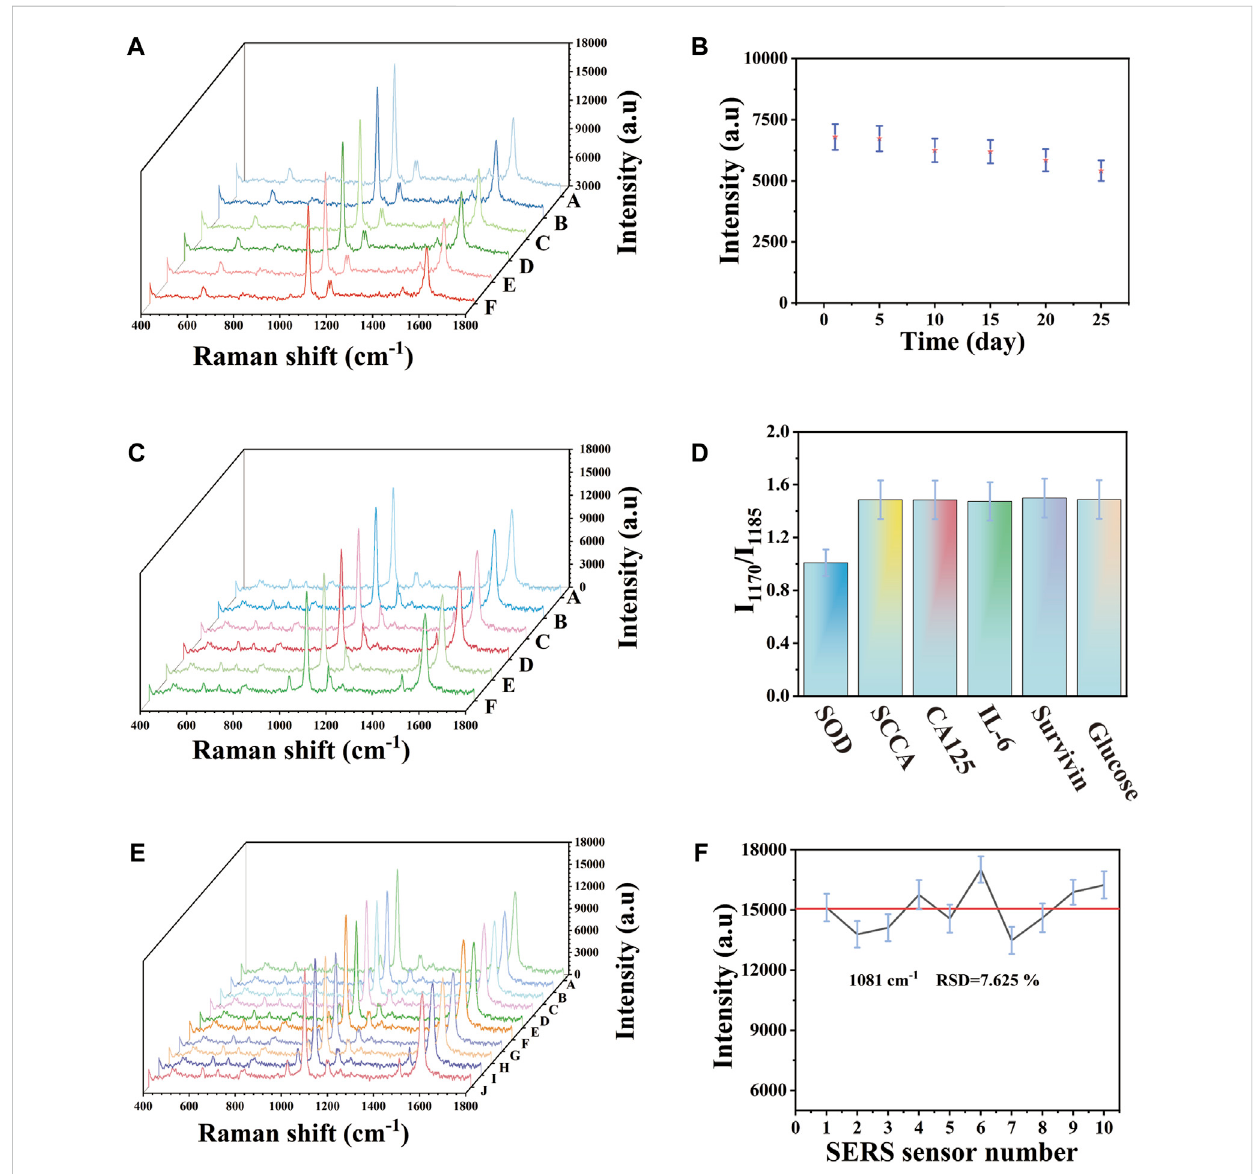
FIGURE 4 (A) SERS spectra of 4-ATP-labeled Au-AgNBs array stored for different days. (B) The scatter graph corresponding to SERS intensity at 1,081 cm − 1 . Speci fi city based on Au-AgNBs array. (C) SERS spectra of analytes (1) SOD, (2) SCCA, (3) CA125, (4) IL-6, (5) survivin, (6) glucose. (B) Histogram corresponding to I 1170 /I 1185 . Reproducibility of Au-AgNBs array. (E) SERS spectrum at 1,081 cm − 1 . (F) Scatter diagram of peak intensity at 1,081 cm − 1